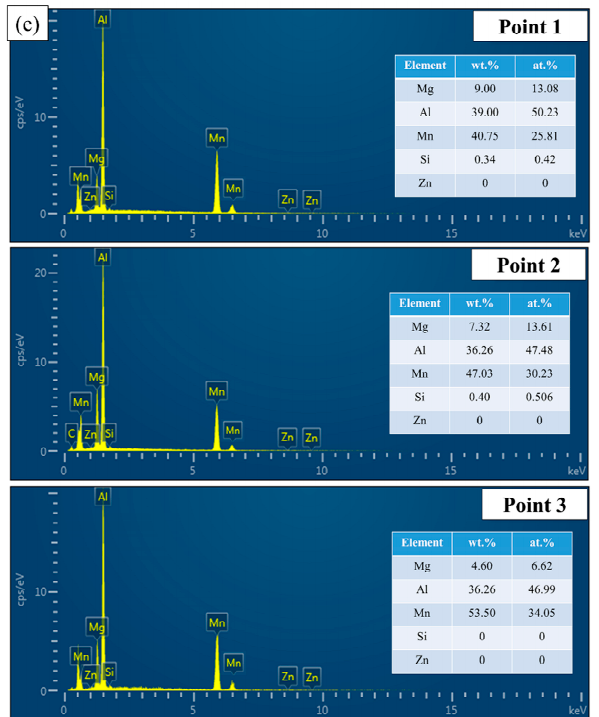
Figure 4. ( a ) OM and ( b ) SEM image of distribution of irregular second-phase particles along extruded strip in compression microstructure; ( c , d ) magnified region of yellow box displayed in ( b ); ( e ) EDS patterns of second phase particles in ( c,d ).